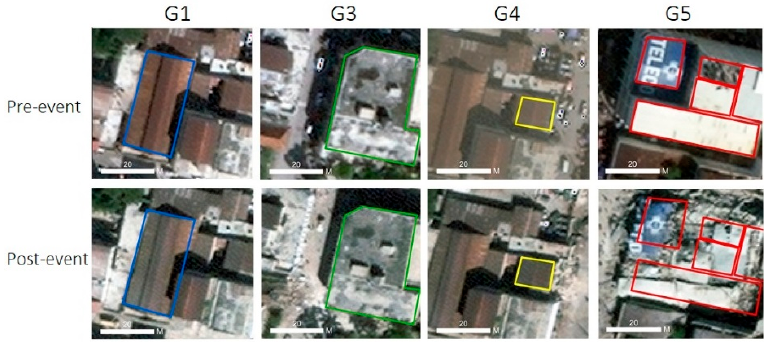
Figure 1. Comparison of pre- and post-event remote sensing imagery for each damage level. (G1: negligible to slight damage; G3: substantial to heavy damage; G4: very heavy damage; G5: destruction.) [24].